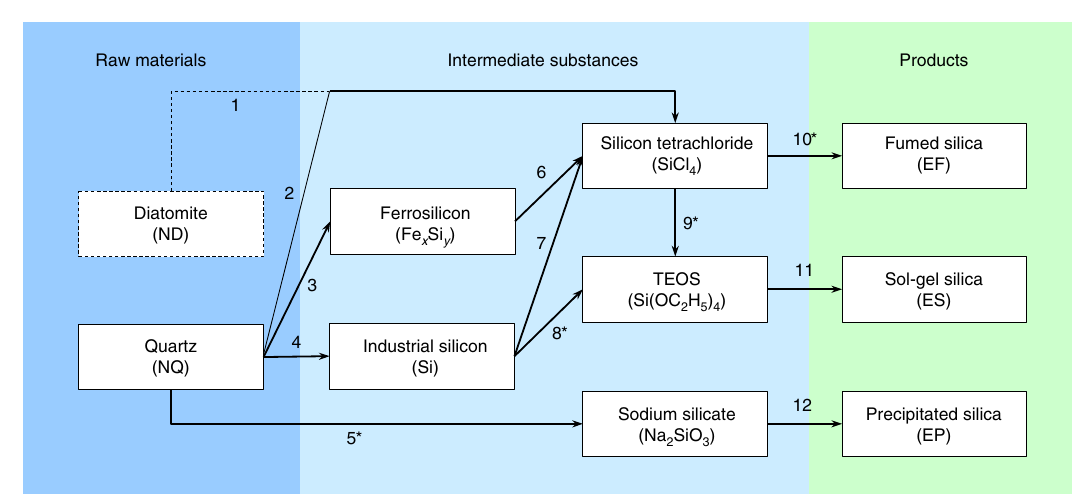
Fig. 3 Scheme showing the industrial synthetic pathways of engineered SiO 2 NPs. The reaction equations 1 - 12 are given in Supplementary Table 8. The key reactions that may cause signi fi cant isotope fractionation of Si or O are marked with asterisks. The dashed line represent a potential but not commonly used route